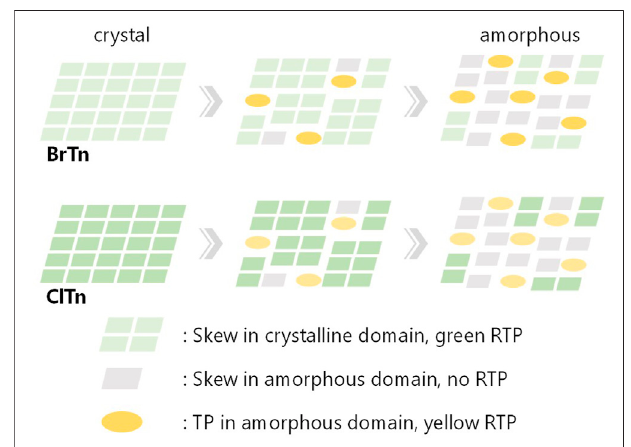
FIGURE 10 | Schematic representation of the proposed mechanism for different mechanoresponse of RTP color, describing the change in conformation and RTP color along amorphization. The relative color depth represents relative PL ef fi